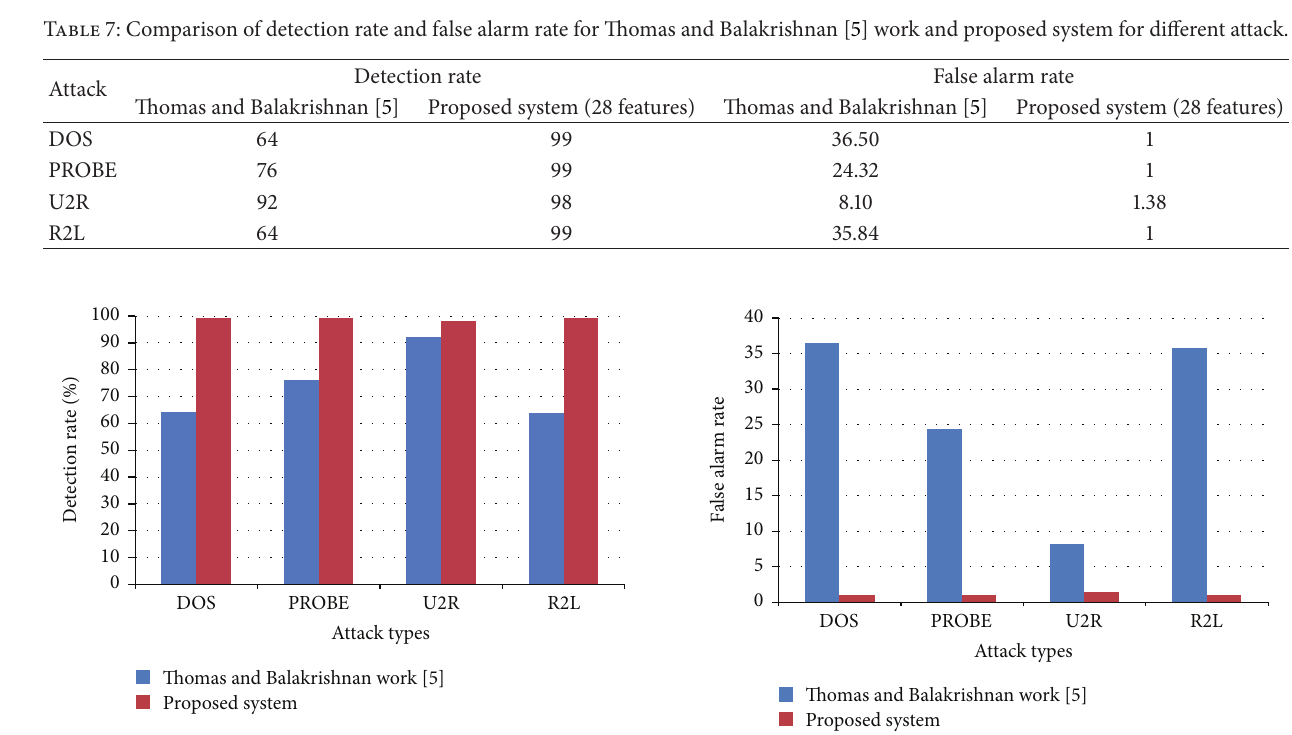
Figure 3: Performance comparison on detection rate of proposed work and Thomas and Balakrishnan [5] work. Figure 4: Performance comparison on false alarm rate of proposed work and Thomas and Balakrishnan [5]